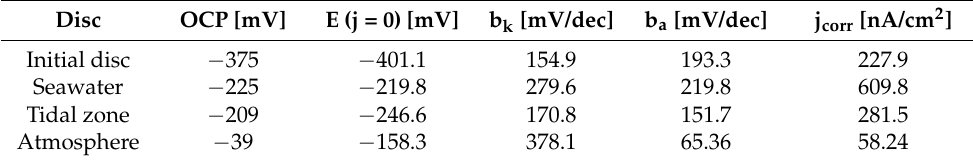
Figure 8. Results obtained throughthe potentiodynamic method. Table 3. Results obtained through the potentiodynamic